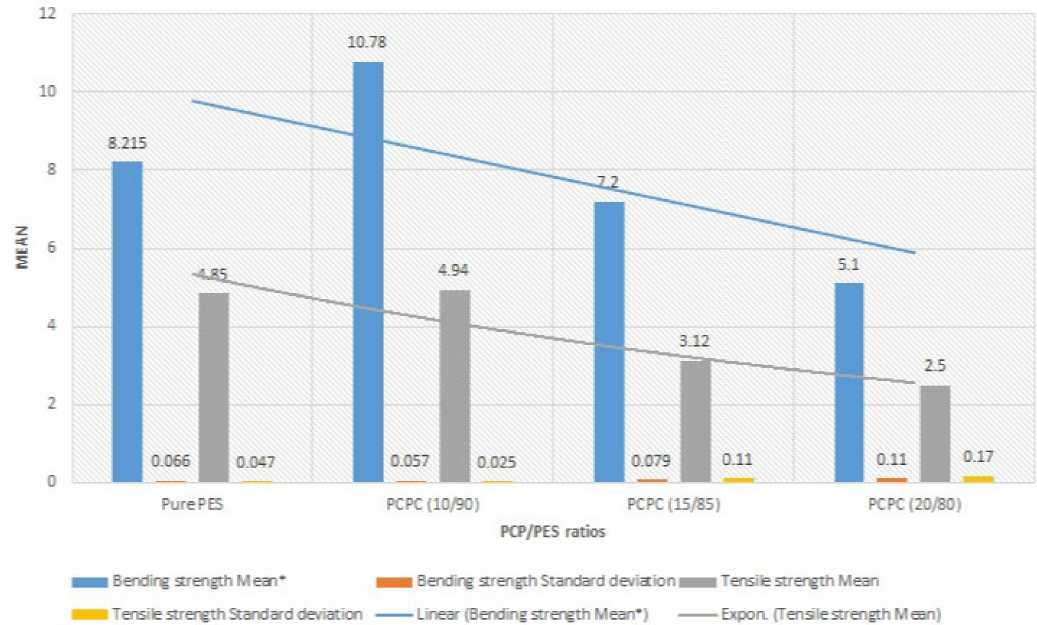
Figure 11. Mechanical properties of the PCPC parts with varying PCP / PES ratios including the standard deviation of the mean. The lower and upper limits of the bending tests were (7.22, 9.22), (10.13, 11.43), (6.55, 7.85), and (4.45, 5.75), respectively, from pure PES to PCPC (20 / 80); and the lower and upper limits of the tensile tests parts were (4.27, 5.43), (4.30, 5.59), (2.47, 3.78), and (1.85, 3.15), respectively, from pure PES to PCPC (20 / 80). Note: the lower and upper limits of the bending and tensile strength are the 95% confidence intervals for the means. *: means any mean value in chart became between the upper and lower